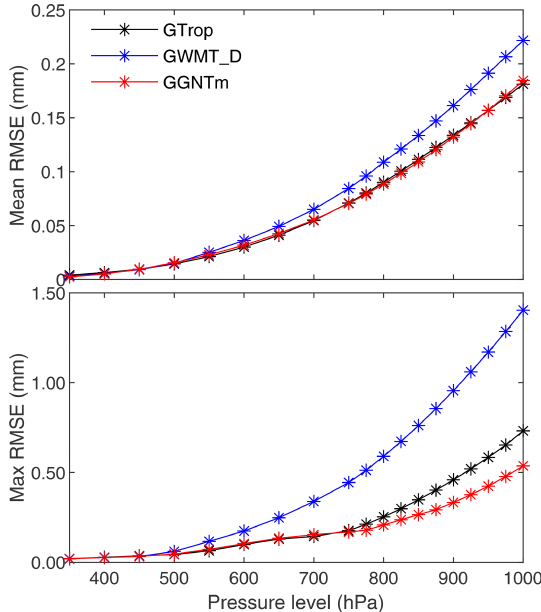
Figure 10. Mean RMSE and maximum RMSE of PWV values at each of the pressure levels at 12:00UTC at all global grid points in 2018 resulting from each of the three models